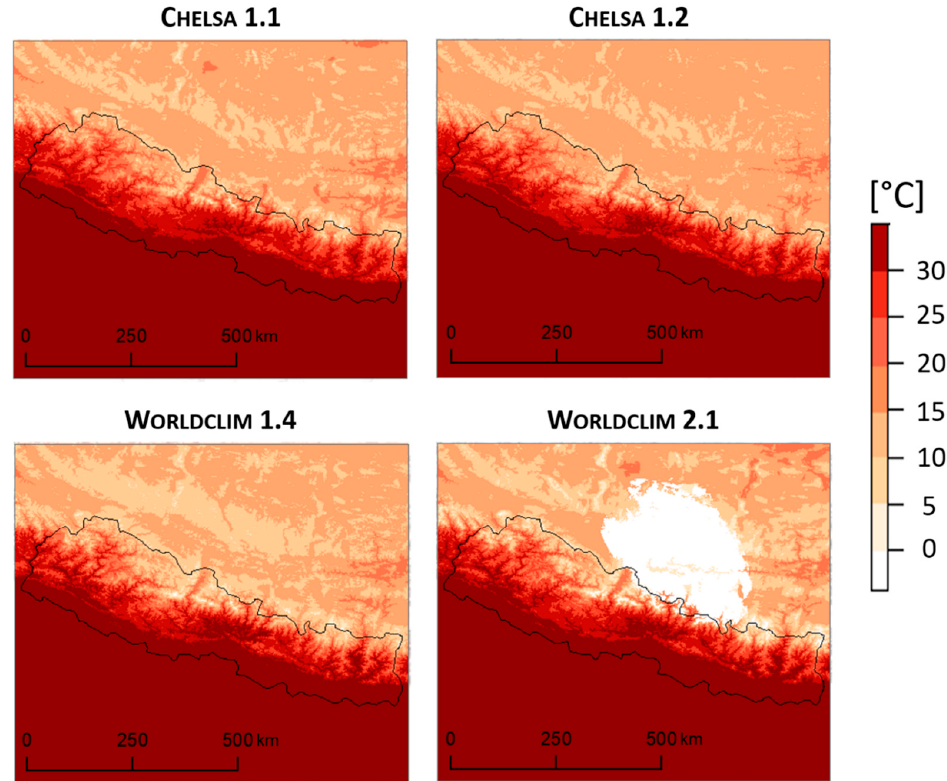
Figure 2. Mean Temperature of Wettest Quarter (i.e., temperature of the growing season) for all climate datasets and respective versions.